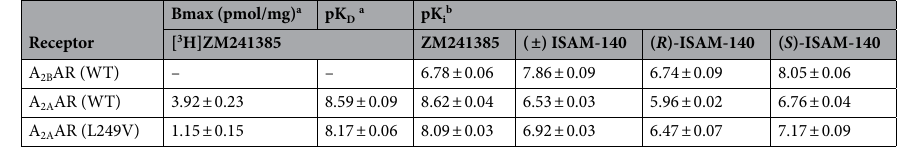
Table 1. B max and pK D values of [ 3 H]ZM241385 and binding affinities of ZM241385, ( ±) ISAM-140, ( R )-ISAM-140 and ( S )-ISAM-140 on WT A 2B AR, WT and L249V 6.51 mutant A 2A ARs. Data is presented as mean ± SEM of three individual experiments, each performed in duplicate. pK D values obtained from homologous competition displacement assays on transiently transfected HEK293-hA 2A AR membranes at 25 °C. pK i values obtained from displacement assays of specific [ 3 H]PSB-603 binding from CHO-spap-hA 2B AR membrane or specific [ 3 H]ZM241385 binding from transiently transfected WT and mutant HEK293-hA 2A AR membranes at 25 °C.